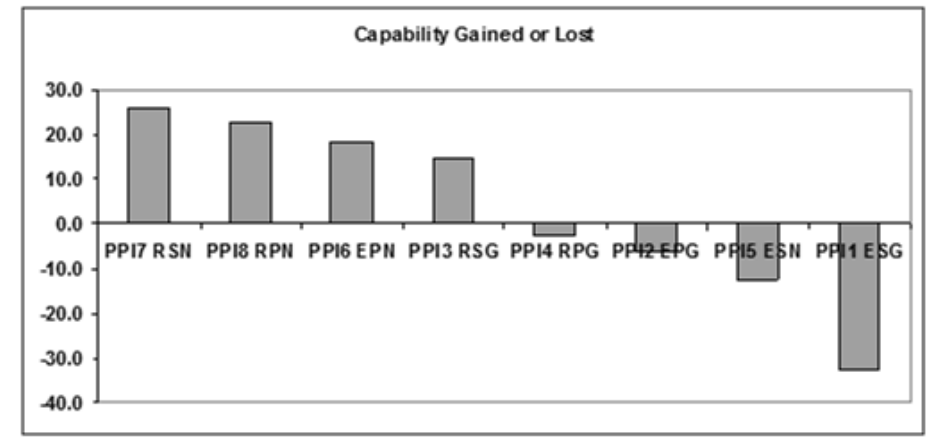
Figure 12. Comparison of Profiles for Capability Gained/Lost